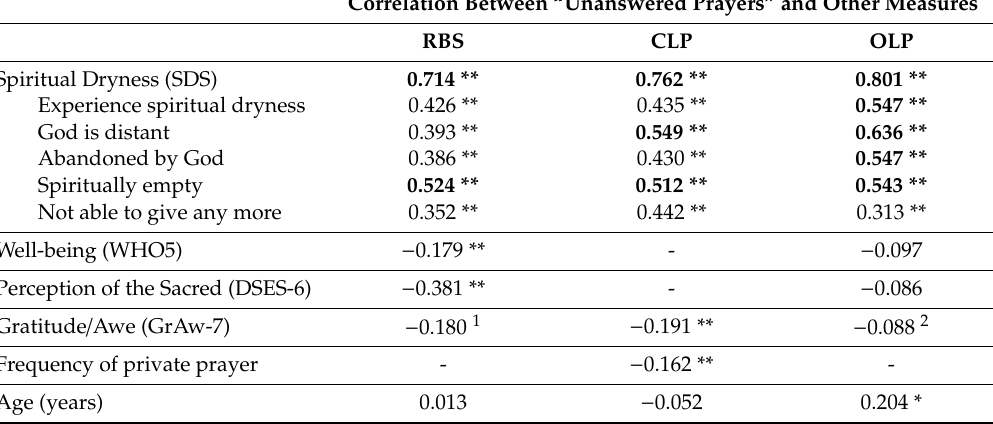
Table 2. Correlation analyses with the three study